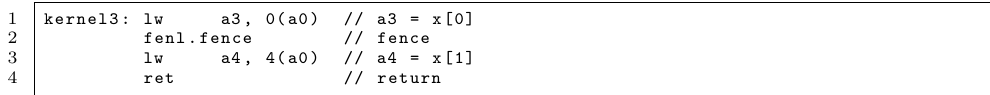
Figure 10: Target kernel for experiment 4: sequential load. Note that the kernel is described post -insertion of fence instructions; the original, pre -insertion version can be inferred by ignoring said instructions (i.e., line